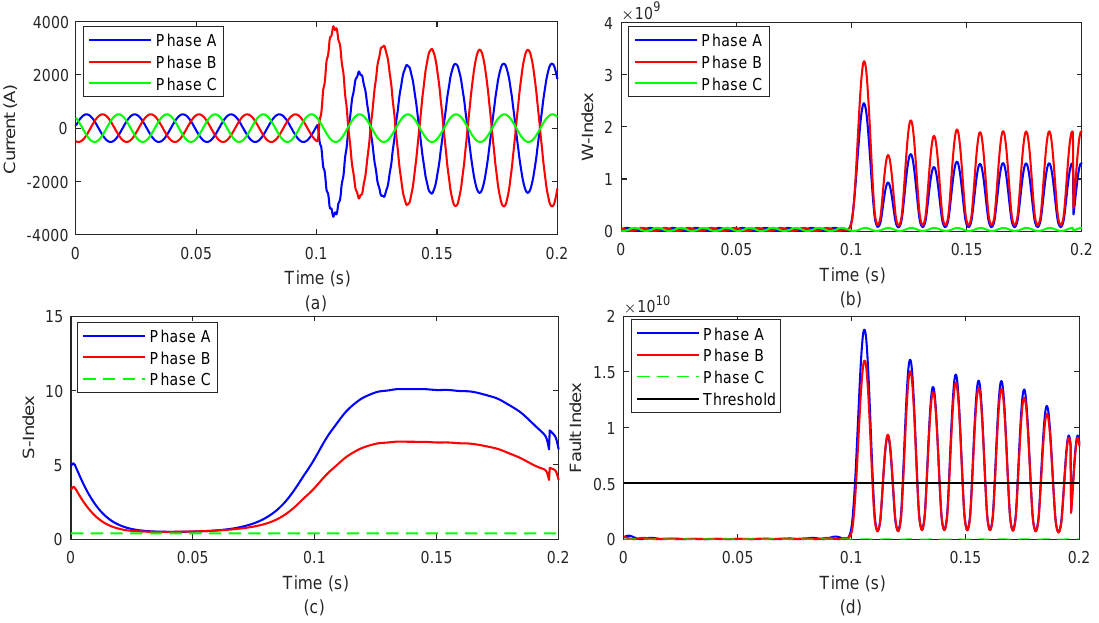
Figure 4. Identification of the fault with an LL nature: ( a ) signals of the current ( b ) W-index ( c ) S-index, and ( d )